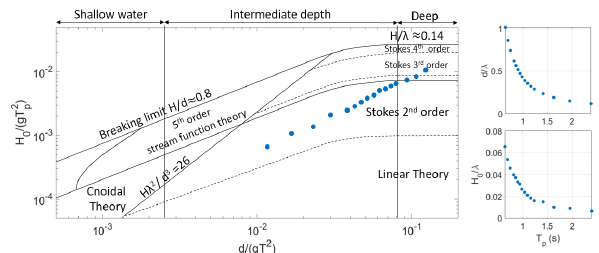
Figure 11. Left : Identification of wave theory according to the validity of several theories for periodic water waves, boundaries defined as in [30]. Right : wave steepness values corresponding to the regular wave tested. H 0 stands for wave height; d for water depth; g is gravity acceleration; T p is wave period; and λ is wave length.